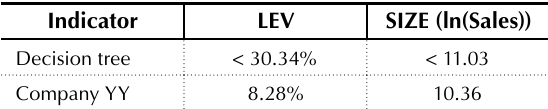
Table 8. Parameters of company YY compared to the decision tree conditions for Cluster 2